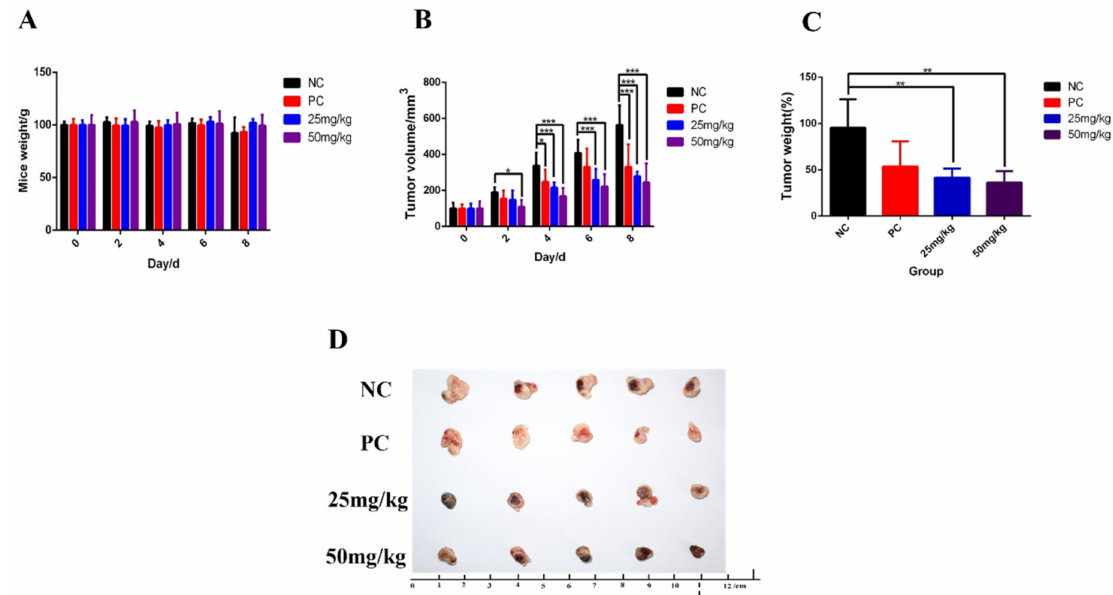
Figure 5. Effects of PPO on ( A ) body weight of mice, ( B ) tumor volume, ( C ) tumor weight. ( D ) Tumor anatomy of mice in each group; bars, SE (* p < 0.05; ** p < 0.01; *** p < 0.001 versus